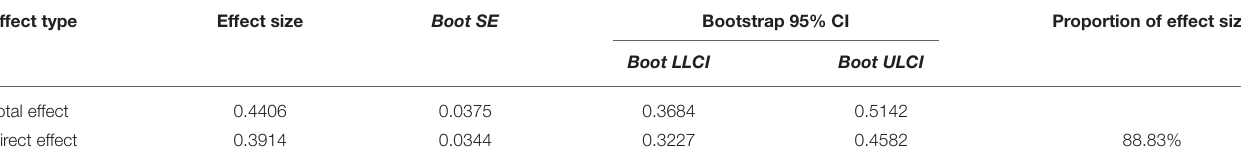
TABLE 3 | Testing the mediating role of social responsibility.